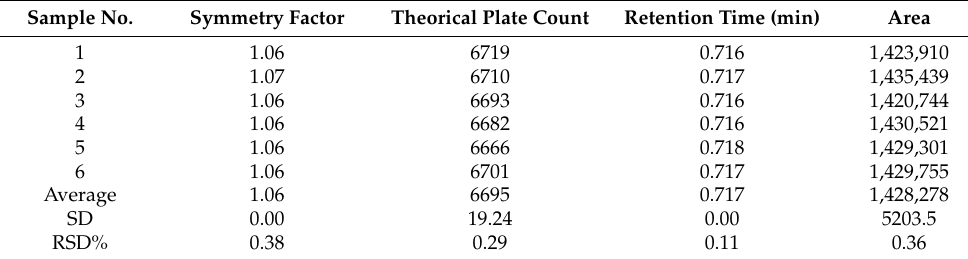
Table 5. Results of System Suitability.